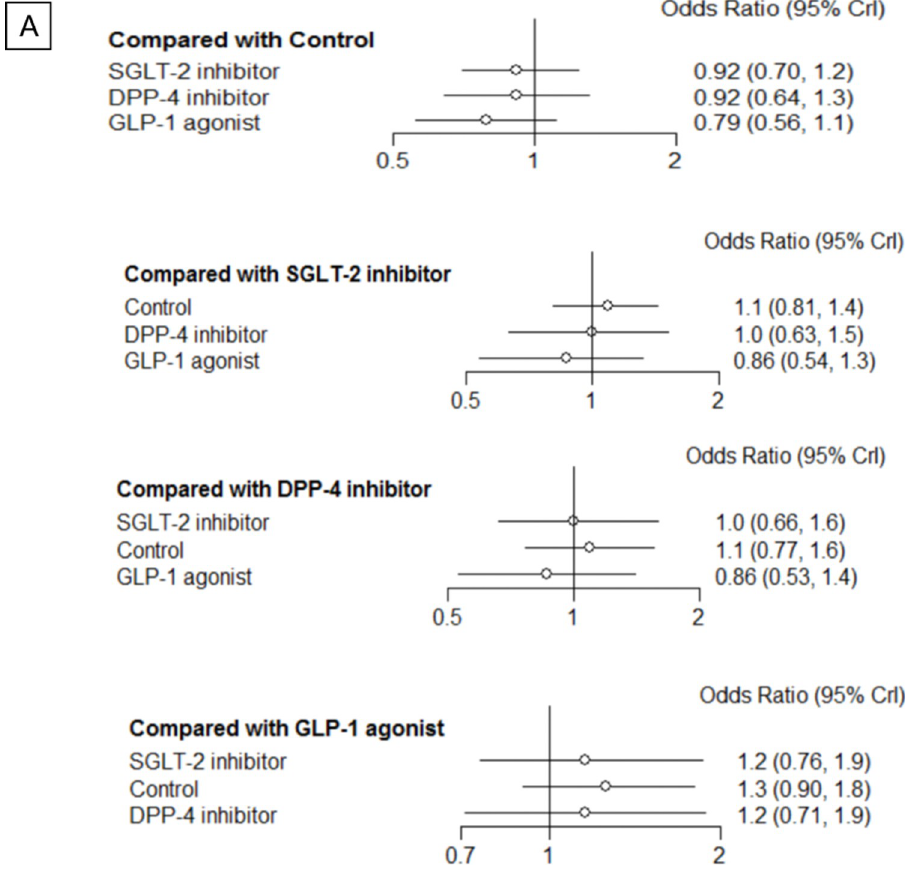
Fig 3. Forest plot for composite renal events (69 trials, 9163 events, 162,959 patients, I 2 = 10%).